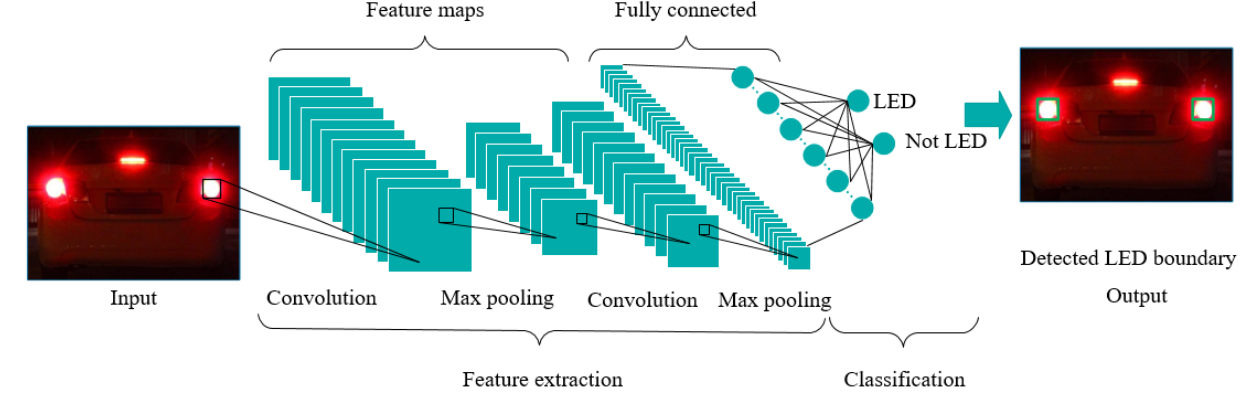
Figure 5. A CNN-based vehicular taillight detection